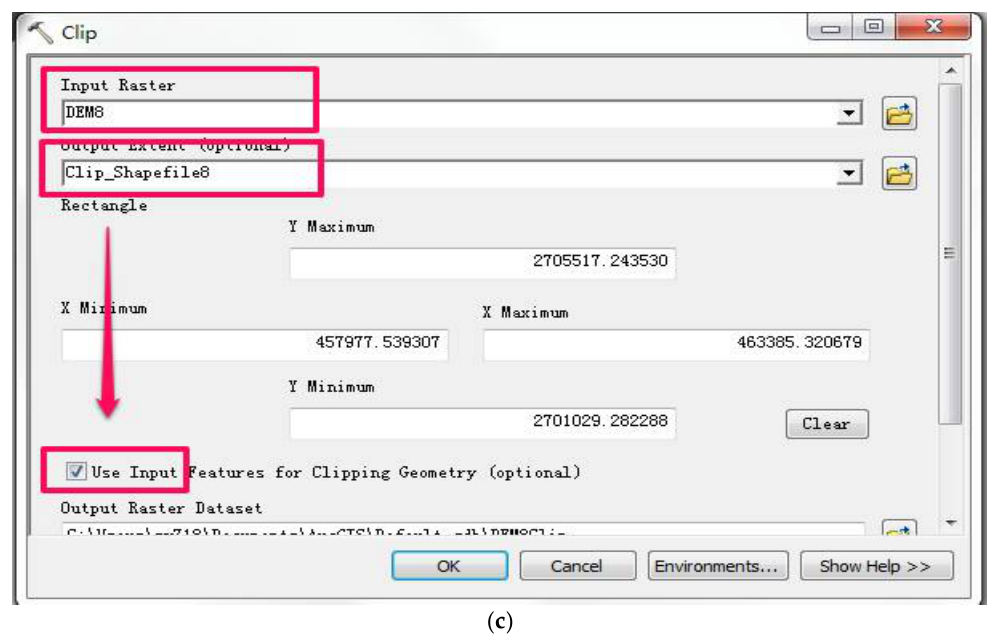
Figure 5. Produce to convert Shape-file to digital elevation model (DEM). ( a ) Creating TIN from Shape-file; and, ( b ) Creating DEM from TIN; and, ( c ) Clipping DEM to obtain that we needed.